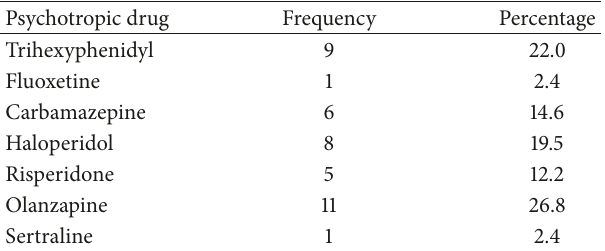
Table 3: Psychotropic drugs prescribed to patients who performed below the cut-off for the